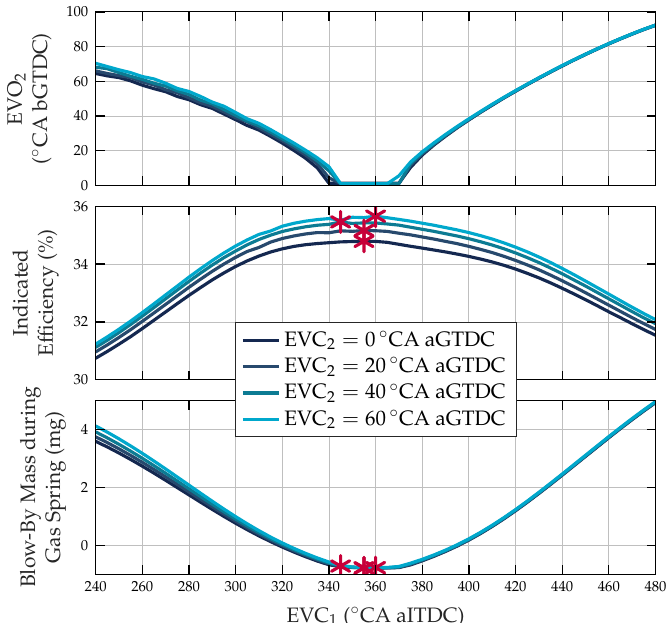
Figure 3. Simulated variations of EVC 1 and EVC 2 for Option 4 and corresponding optimization of EVO 2 during 12-stroke operation. EVC 1 indicates the transition point into gas spring operation, EVO 2 the transition point out of gas spring operation. A negative blow-by mass flow means that gases flow from the crankcase into the cylinder.